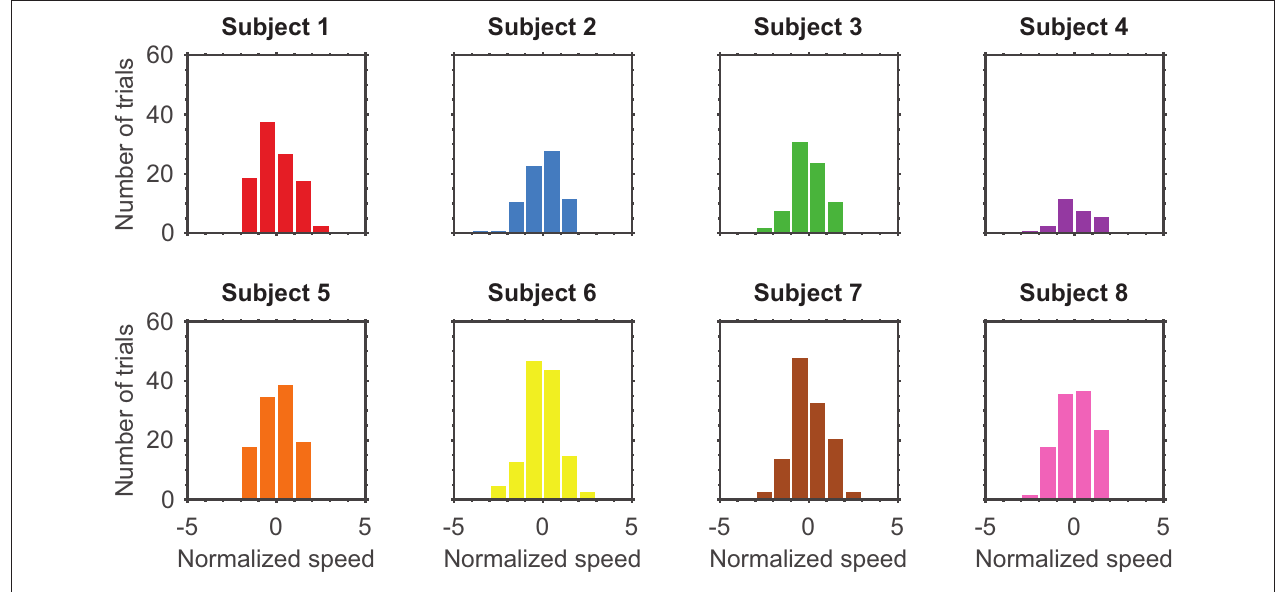
FIGURE 3 | Distribution of normalized speeds across all trials for eight subjects with a bin width of one.